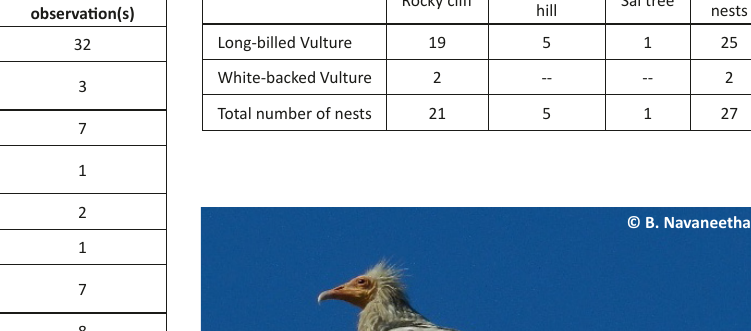
Table 3. Nesting sites of Long-billed Vulture and White-backed Vulture in Bandhavgarh Tiger Reserve Bhandani Rocky cliff hill